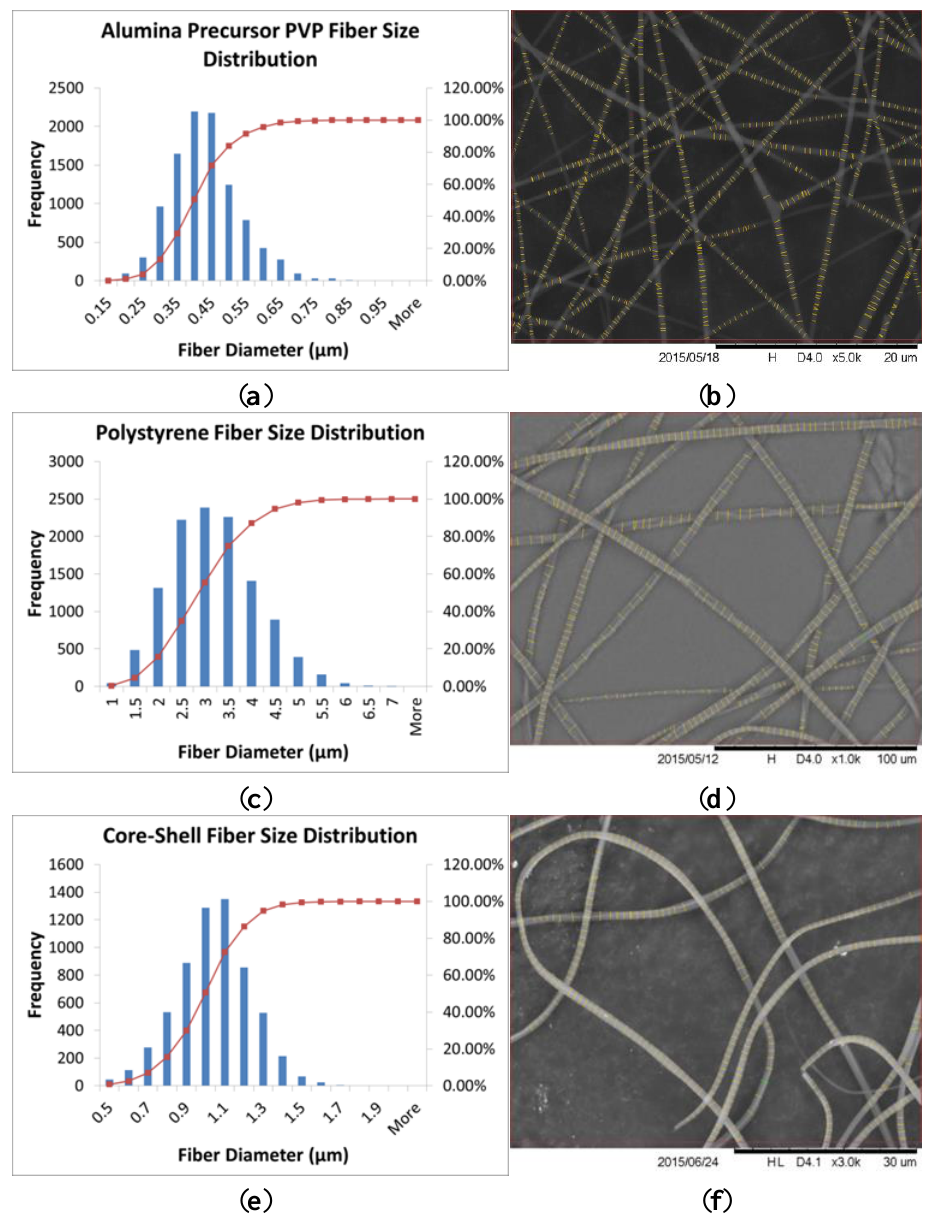
Figure 5. Fiber size distribution analysis histograms and sample SEM images after FibraQuant™ analysis for ( a , b ) alumina precursor PVP; ( c , d )